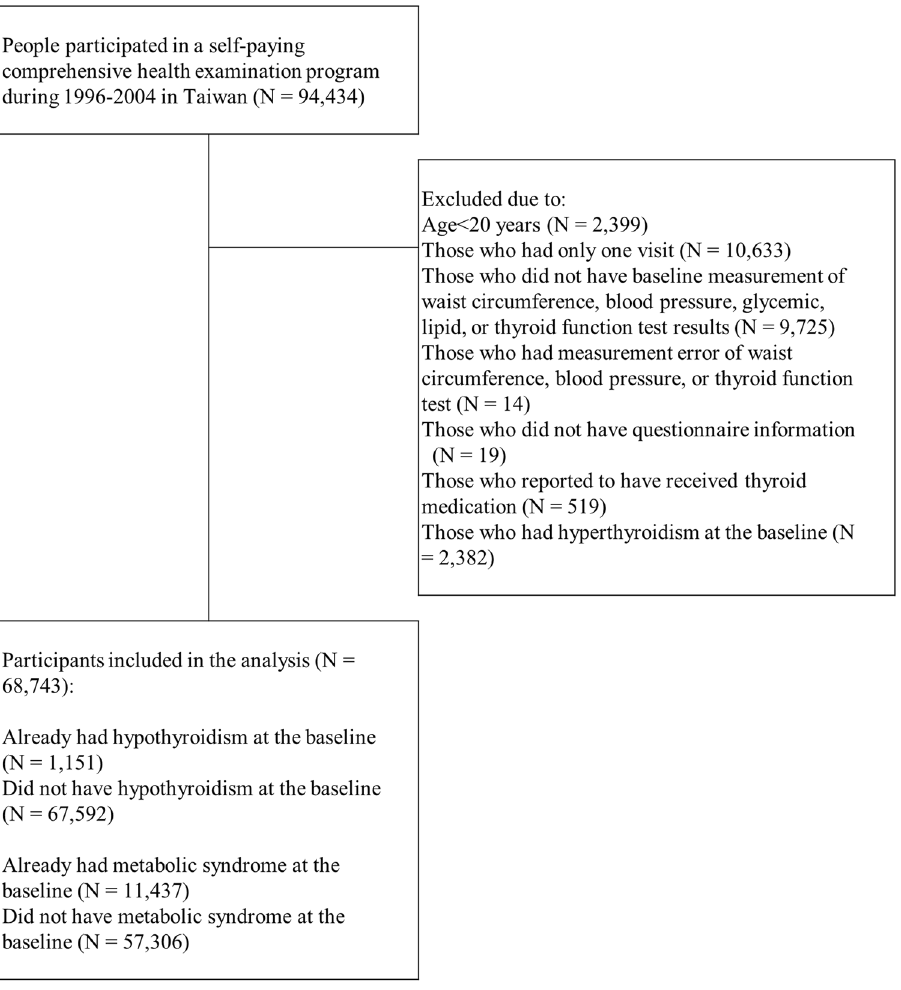
Figure 1. Flow chart for study participants’